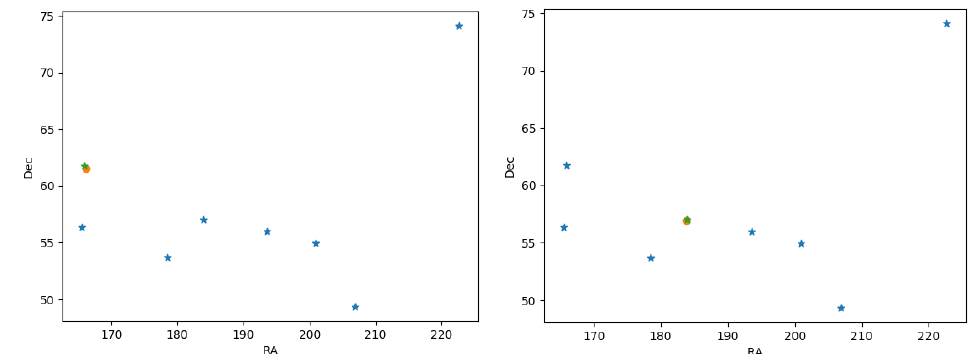
Figure 16. Orientation error example: the “Big bear” stars constellation in Ra , Dec coordinates (angular). Left: a 0.3 ◦ error-accuracy, the estimates orientation is marked by an orange circle, in green - the real image-based pixel of the tested star (“Dubhe”). Right: a 0.1 ◦ error-accuracy, the estimates orientation is marked by an orange circle, in green, the real image-based pixel of the tested star (“ δ UMa”). The difference in the orientation accuracy is mainly due to the location of the tested star in the image. Stars within the 30 ◦ FOV tends to have a sub 0.1 ◦ error angular